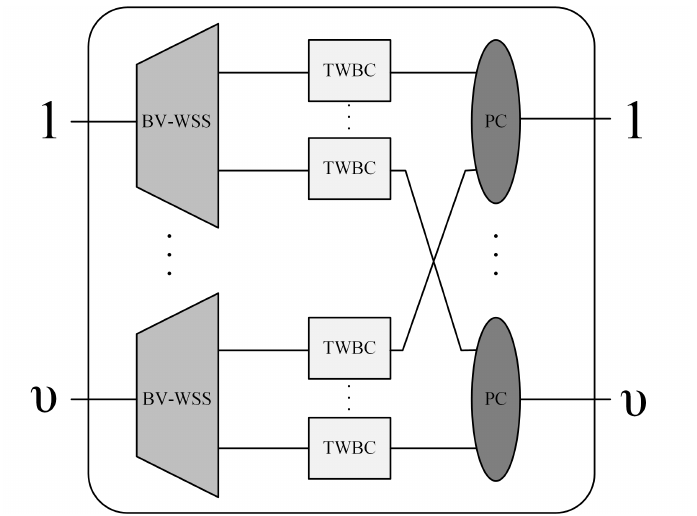
Figure 3. A first/third stage switch. BV-WSS—bandwidth variable wavelength selective switch; TWBC—tunable waveband converter; PC—passive